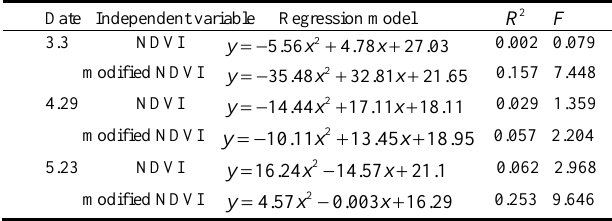
Table 5. 20cm soil moisture regression model in northern Henan